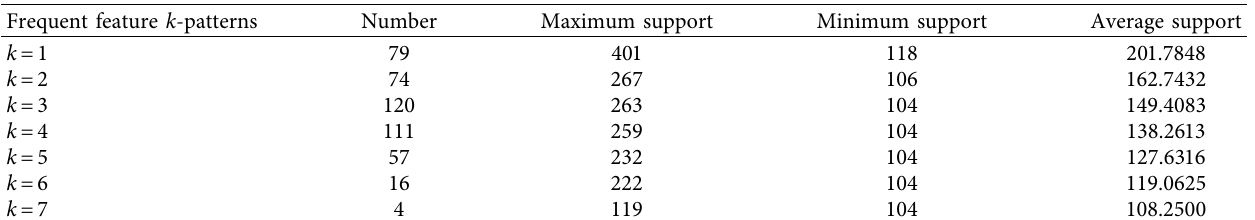
Table 12: Frequent feature pattern mining results based on the DST discriminant criterion. Frequent feature k